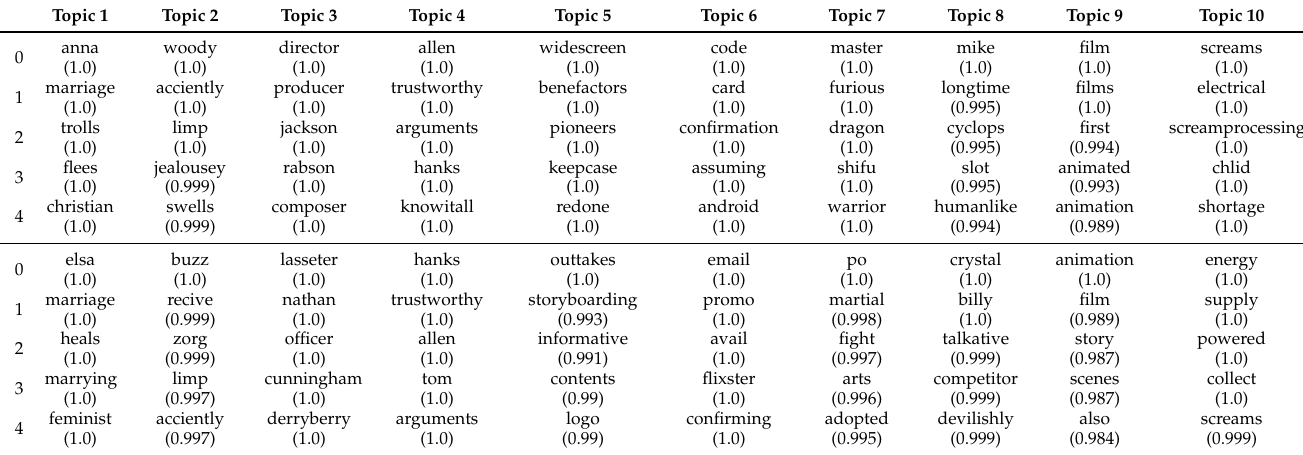
Table A19. For the most significant two words per topic, the four nearest neighbors based on cosine similarity are listed.